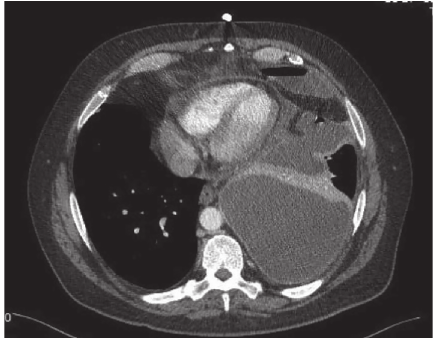
Figure 2: CT on initial